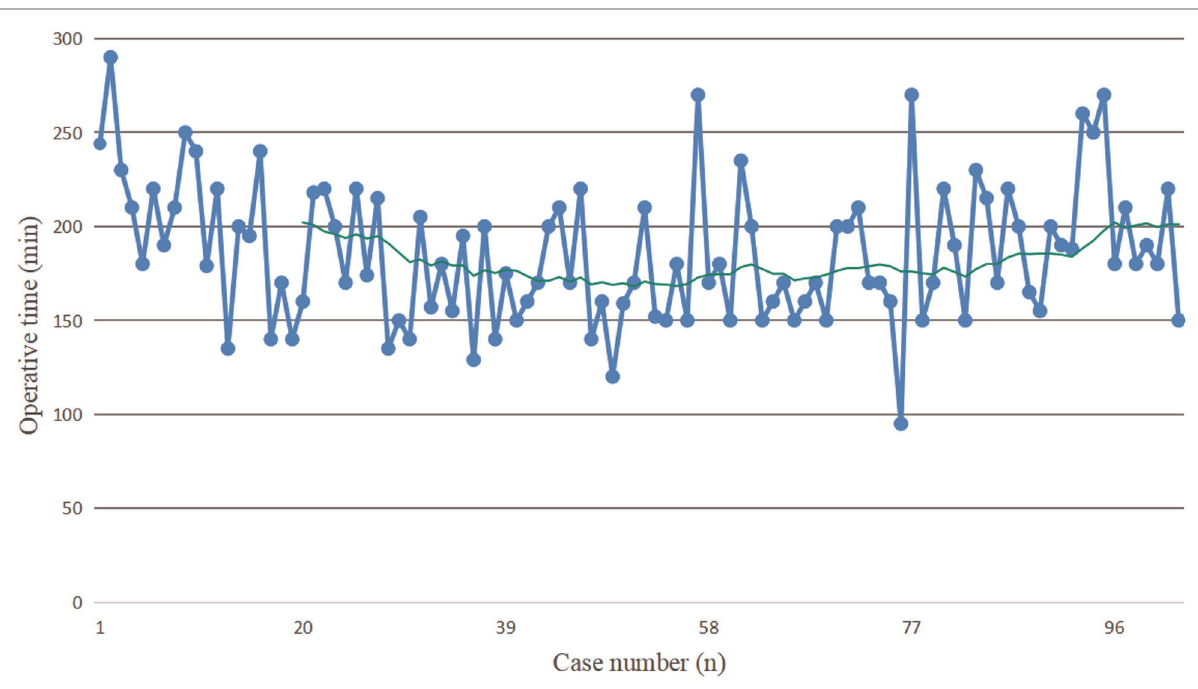
FIGURE 1 The blue solid points indicate the operative time for each patient in chronological case order. The green line represents the moving average of operative time, which is used to help determine the trend of operative time. In the initial period of developing robotic SADI-S, the slope of operative time goes down most sharply, then tends towards